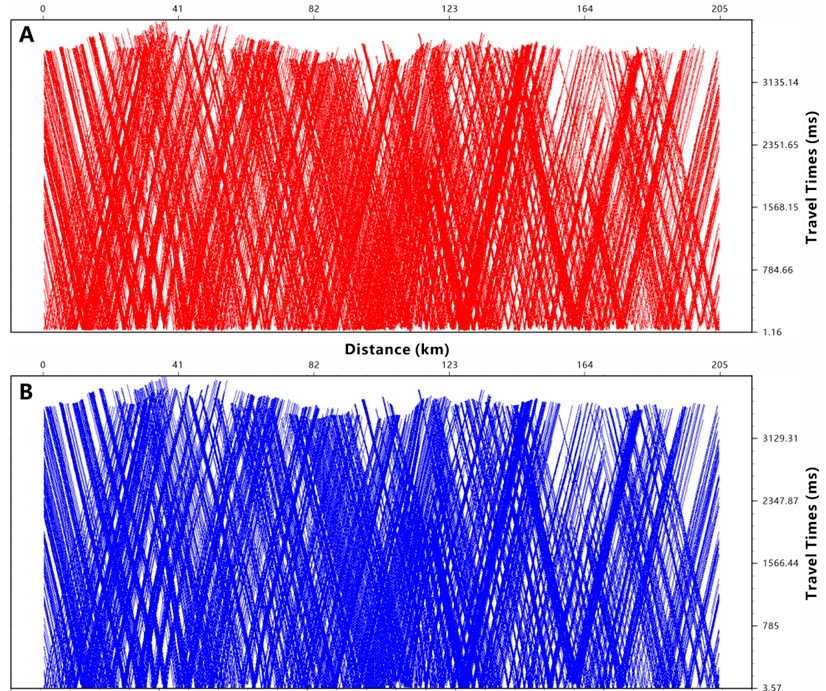
Figure 7. ( A ) Picked first-arrival times (red) and ( B ) theoretical first-arrival times (blue) after tomographic inversion.